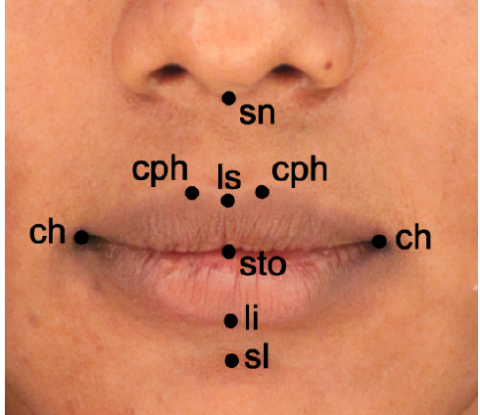
Figure 1. Digitized 3D labial landmarks used in the current study (sn, subnasale; ls, labiale superius; sto, stomion; li, labiale inferius; sl, sublabiale; cph, crista philtri; ch, cheilion).